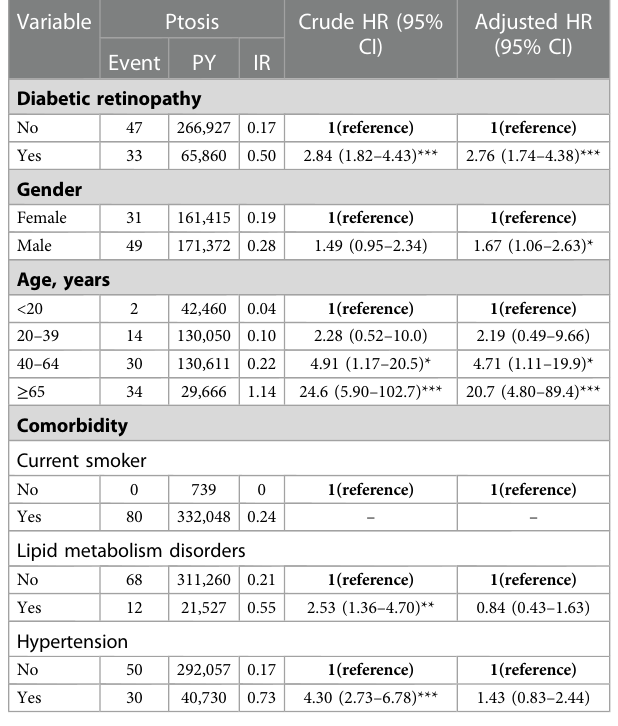
TABLE 2 Cox model measured hazard ratios and 95% con fi dence interval of ptosis associated with gender and age.